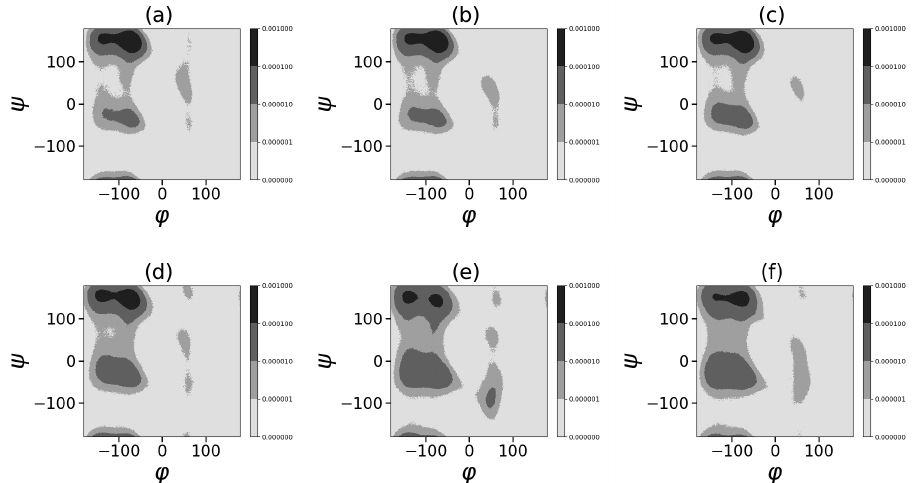
Figure 10. Ramachandran plots. DGL1 at different methanol volume fractions φ : ( a ) 0.2, ( b ) 0.4,